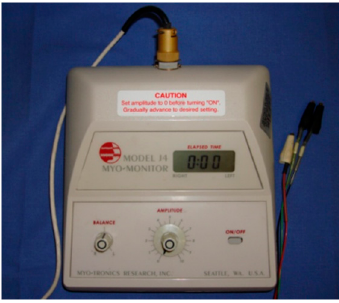
Figure 3. K6-I electromyograph (Myotronics, Tukwila, WA, USA).